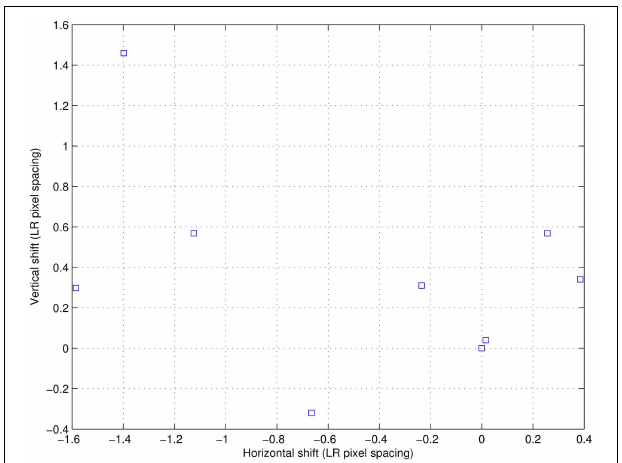
FIGURE 13 | The estimated shifts for the nine real LR frames (data set I).